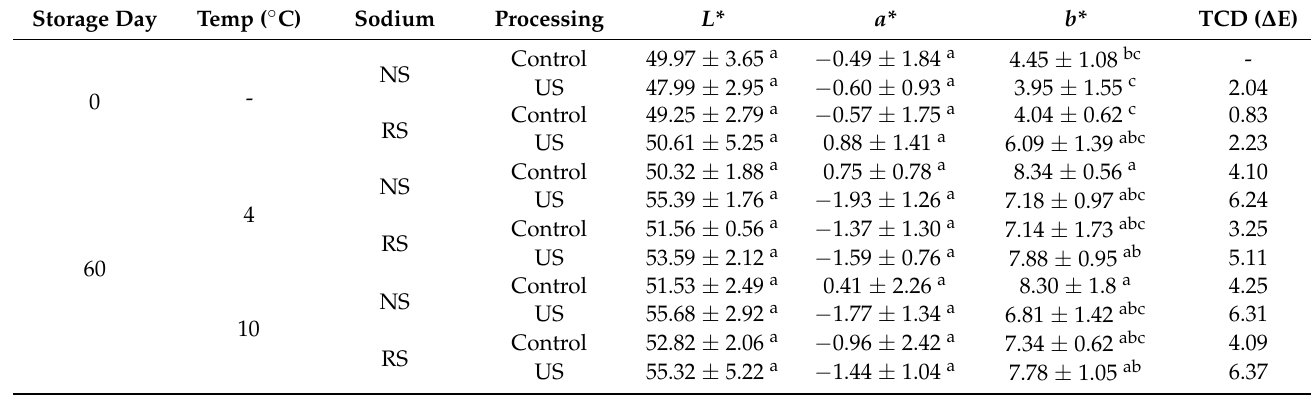
Table 2. Colour parameters and total colour difference (TCD) of brined pork at day 0 and after 60 days of storage: values represent means ± standard deviation (SD, N = 3) of ultrasound-assisted (US) meat containing standard (NS) or reduced sodium content